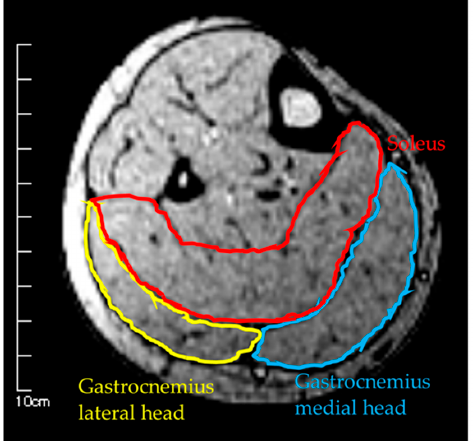
Figure 2. Measurement of muscle cross-sectional area by MRI.